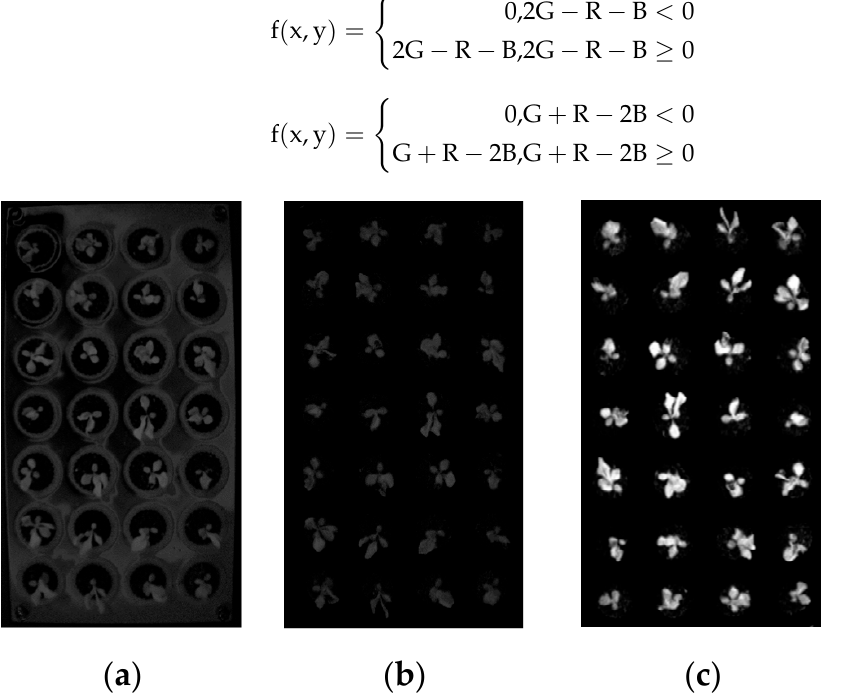
Figure 4. Gray image of lettuce plug seedling with seedling age of 17 d. ( a ) 2G-R-B; ( b ) G+R-2B; ( c ) automatic tone correction.